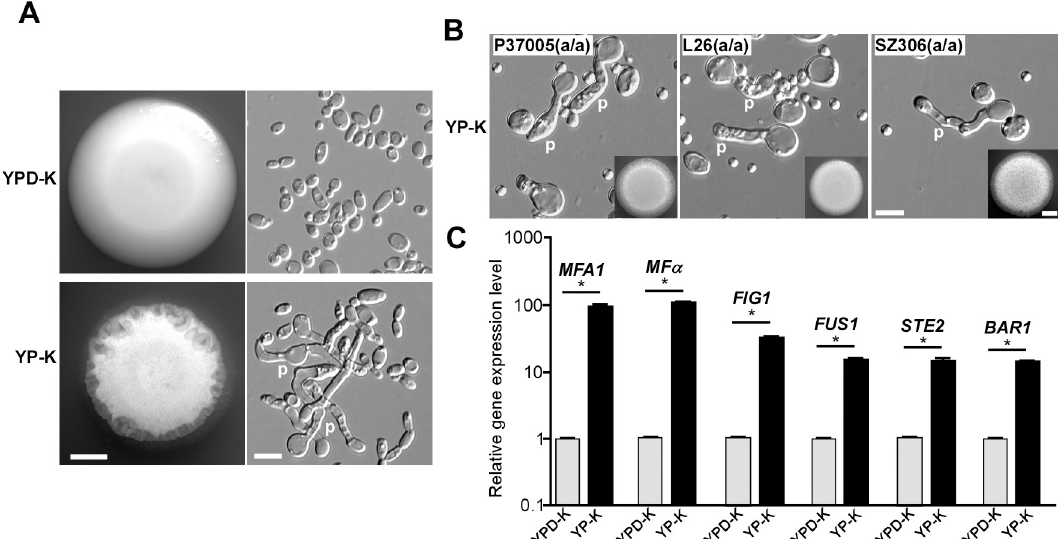
Fig 1. Glucose starvation promotes efficient polarized cell growth and induces the expression of mating-related genes in MTL a/ a cells of C . albicans . (A) Morphologies of the laboratory strain GH1013 ( MTL a / a ) grown on YPD-K and YP-K media. 1 × 10 5 cells were spotted on YPD-K and YP-K media and cultured at 25˚C for five days. Scale bar for colonies (left panels), 2 mm; scale bar for cells (right panels), 10 μ m. (B) Morphologies of three clinical C . albicans strains ( MTL a / a )grown on YP-K medium at 30˚C for four days. Scale bar for colonies (inset), 2 mm; scale bar for cells, 10 μ m. (C) Relative expression levels of mating-related genes normalized to ACT1 . Cells of GH1013 were used, and culture conditions were same as described in panel (A). Error bars represent standard errors of technical duplicates. � p < 0.05, two-tailed Student t test. Experiment was repeated in a biological replicate, and a representative image is shown. The numerical data are presented in S3 Data . ACT1 , ACTin 1; Bar1, BARrier 1; FIG1 , Factor-Induced Gene 1; FUS1 , cell FUSion 1; MFA1 , Mating type A1; MF α , Mating α factor precursor; MTL , Mating type locus; p, mating projection; STE2 , STErile 2; YPD-K, yeast extract-peptone-glucose-K 2 HPO 4 ; YP-K, yeast extract-peptone-K 2 HPO 4